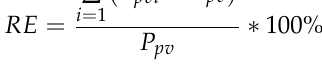
18 of 23 Figure 19. PV-TEG emulator hardware setup. A comparison of the experimental data between GRNN-GWO and GRNN-OPA is given in this section. As shown in Figure 20, GRNN-PSO tracks and settles at GMPP in 150 ms with a power of 43.48 W , which is lower than the power recorded by GRNN-OPA. Due to the successful prediction of the suggested approach, Figure 21 illustrates the GRNN-OPA tracking the maximum power in a short amount of time. GRNN-OPA has a considerable amount of power. Our approach takes milliseconds to monitor GMPP, and the power recorded is 46.55 W .